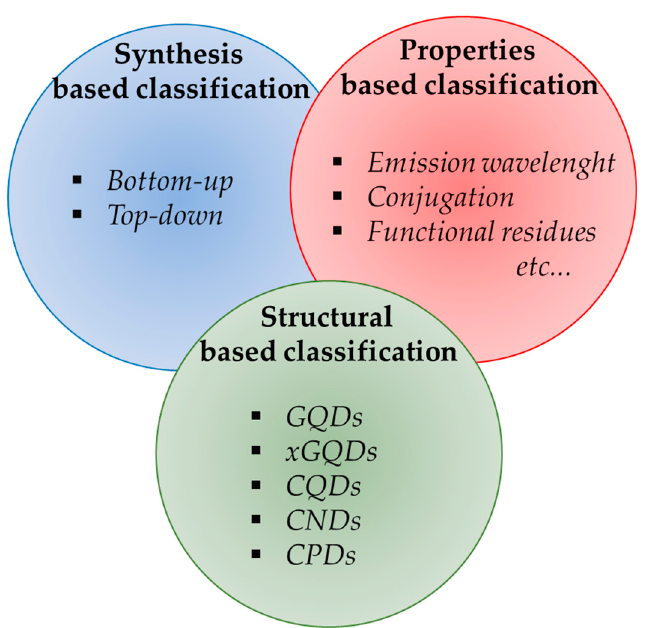
Figure 3. Scheme of possible classi fi cation of CDs based on synthetic approach, properties and structural features.